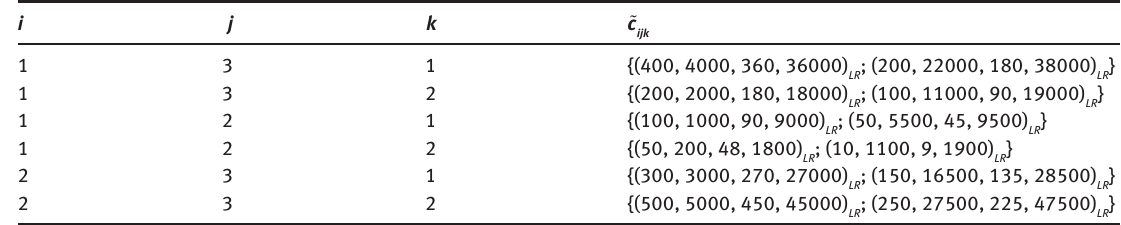
Table 3: Intuitionistic Fuzzy Cost (